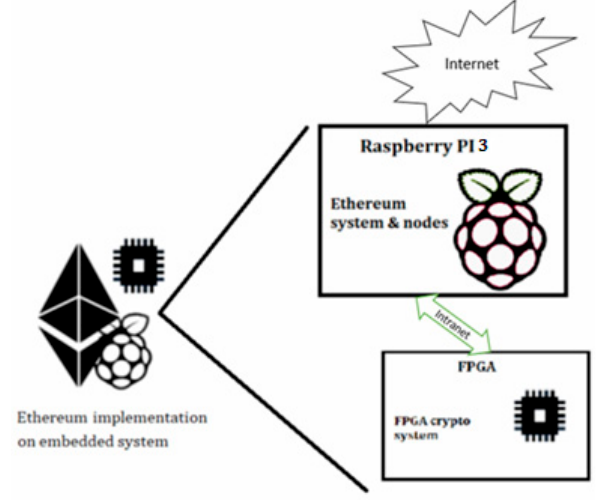
Figure 3. Permissioned Ethereum architecture implementation.